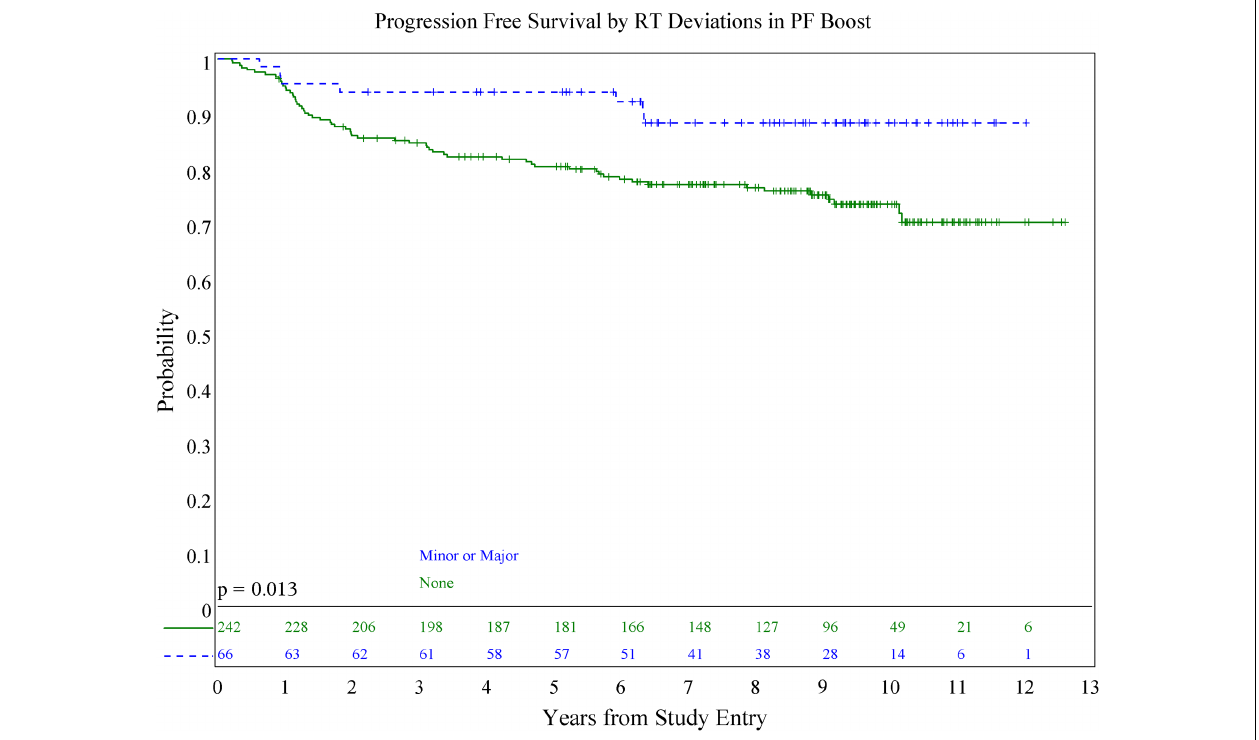
FIGURE 5 |Association of posterior fossa deviations and progression-free survival.